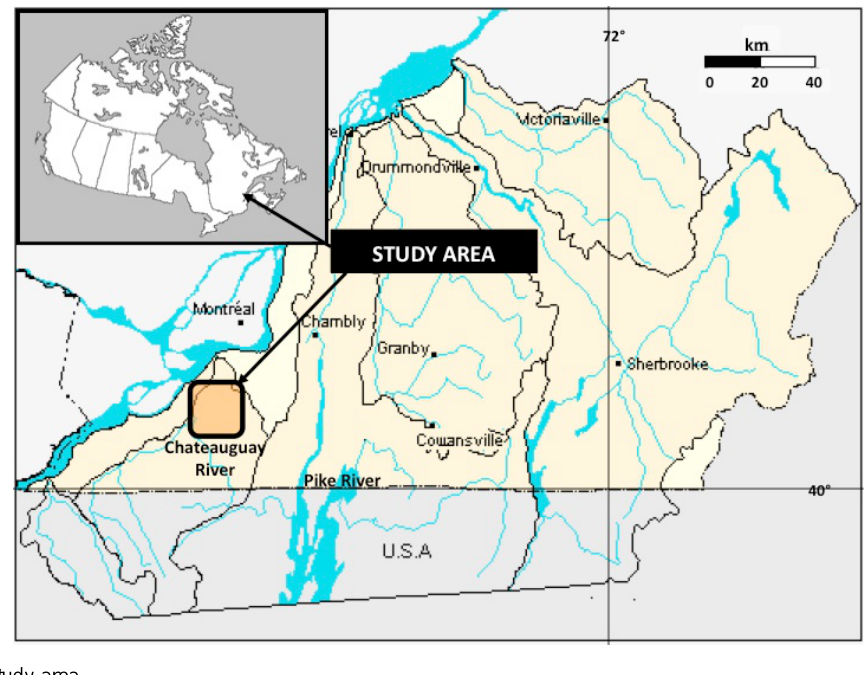
Fig. 1. Location of study area.